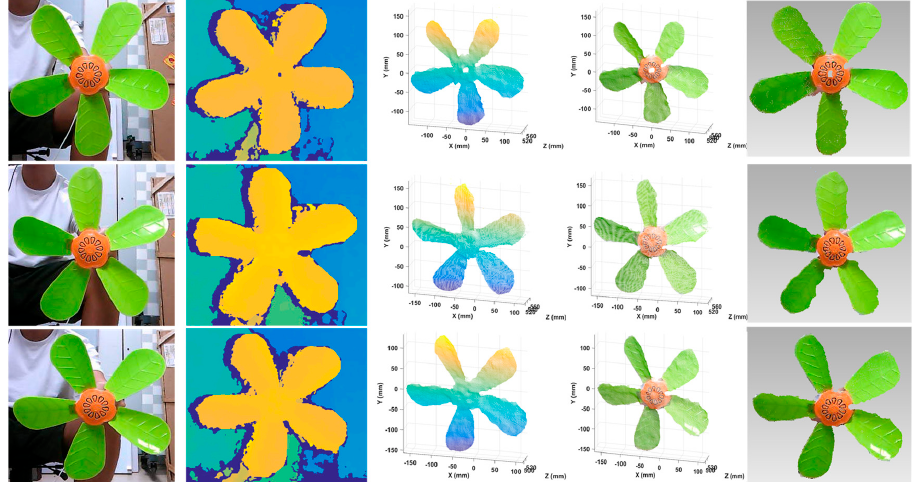
Figure 16. Reconstruction results of a working fan using the proposed system. From left to right: original images, estimated depth maps, reconstructed point clouds, point clouds with textures, and 3D models.